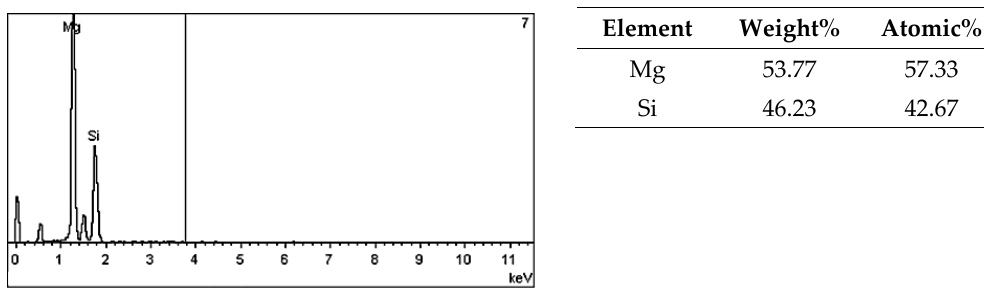
Figure 11. EDS diagram and chemical composition at point no. 6 of Figure 5.